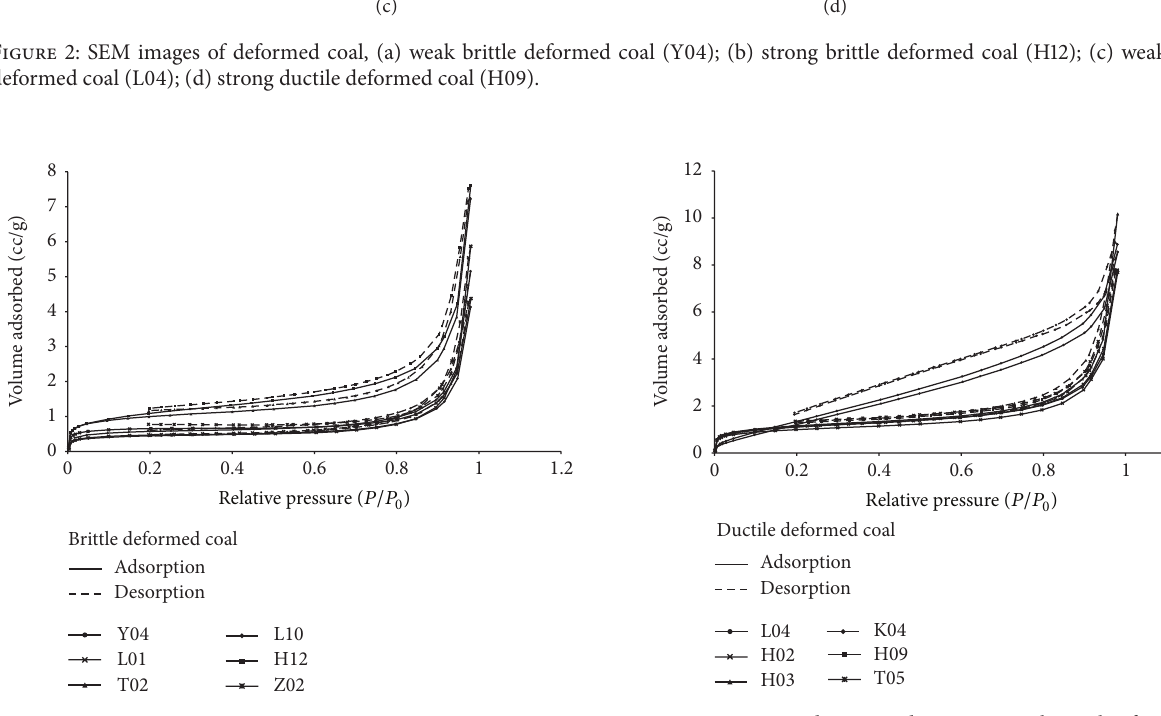
Figure 3: N 2 gas adsorption/desorption isothermals of six brittle deformed coals.